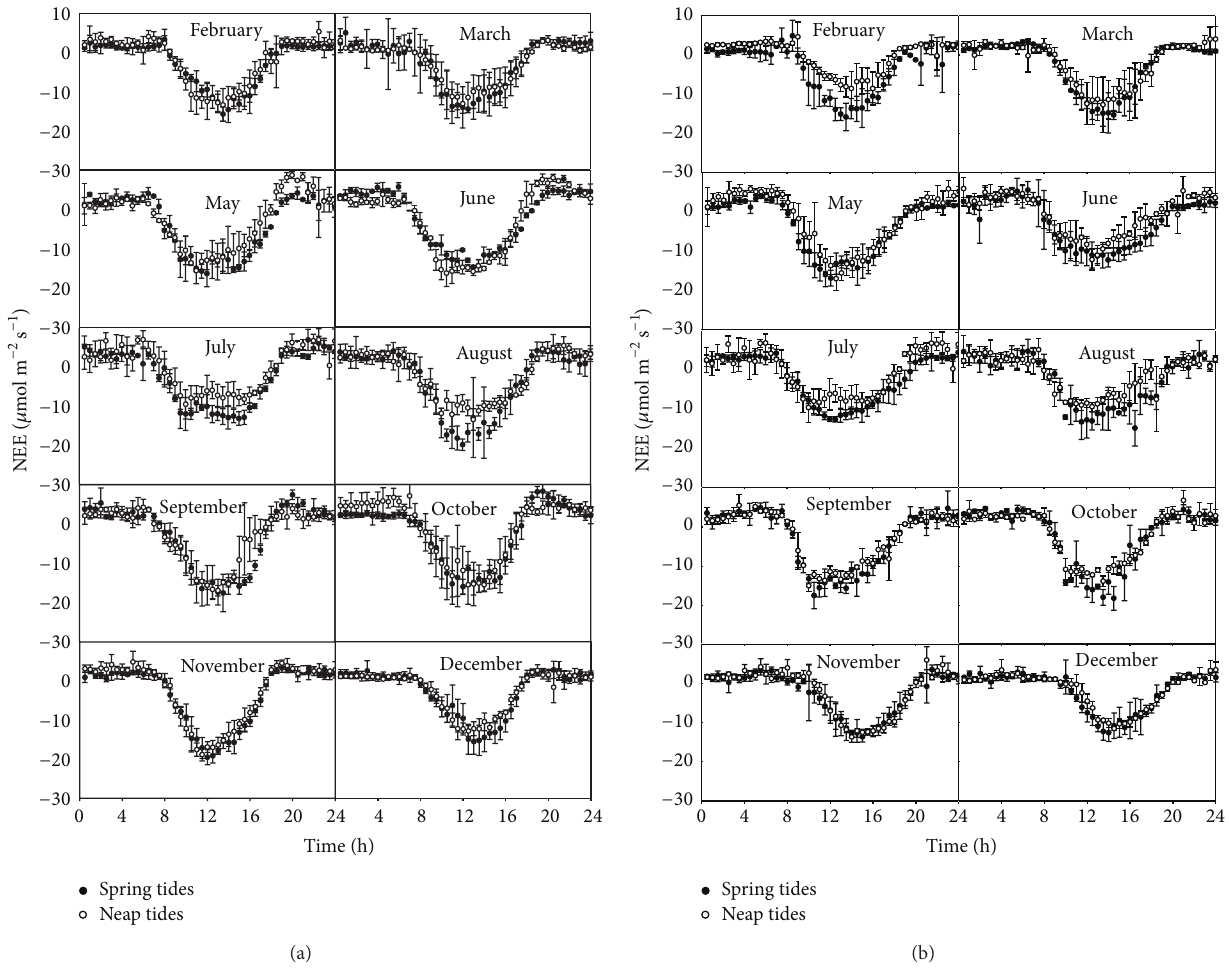
Figure 4: Average diurnal NEE for the selected days within spring tides or neap tides in each month of 2010 ((a) FJZZ and (b) GDZJ). The bars represent the standard deviations around the mean ( 𝑛 = 3